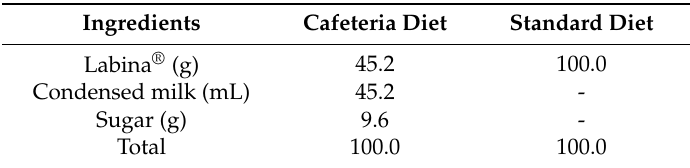
Table 1. Diets used in the